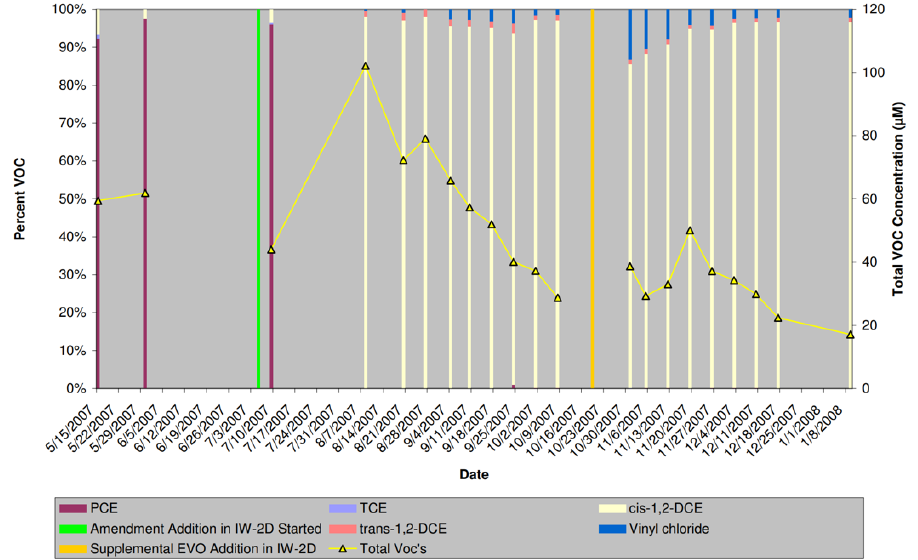
Figure 9. Comprehensive test cell data summary: EVO + hydrogen gas, IW-3D/IW-2D, IW-3D % VOC, and total VOC concentration.